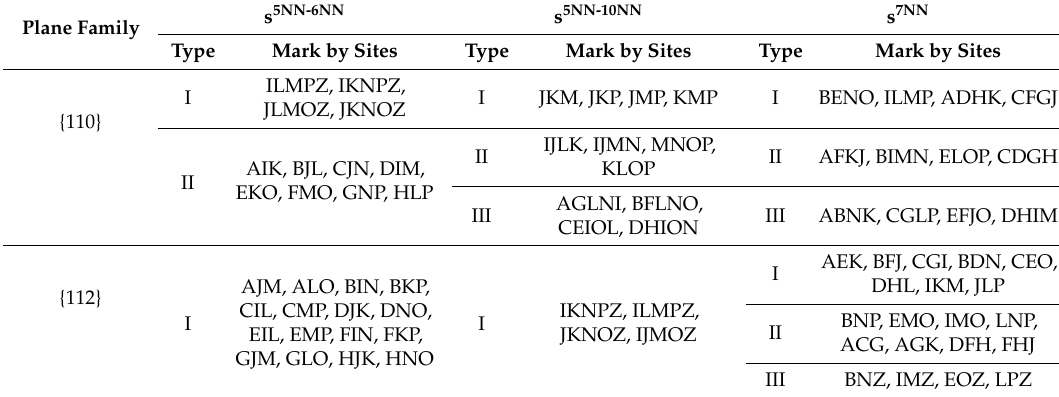
Table 4. The {110} and {112} planes decided by the s 5NN-6NN , s 5NN-10NN , and s 7NN as well as the selected reference hydrogen atom